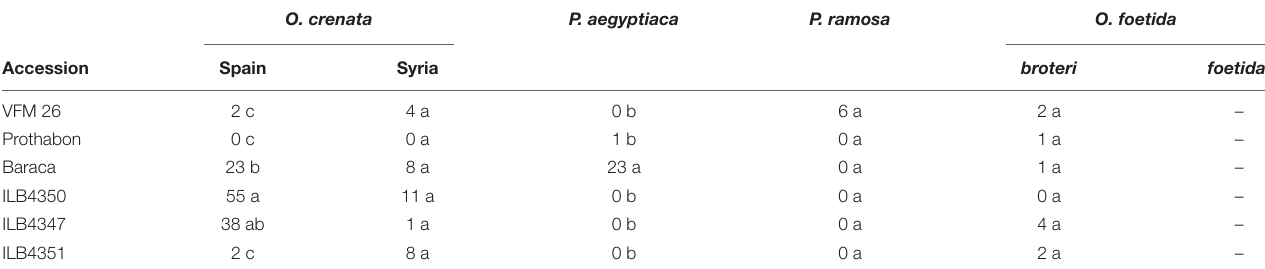
TABLE 7 | Percentage of established broomrape tubercles that became